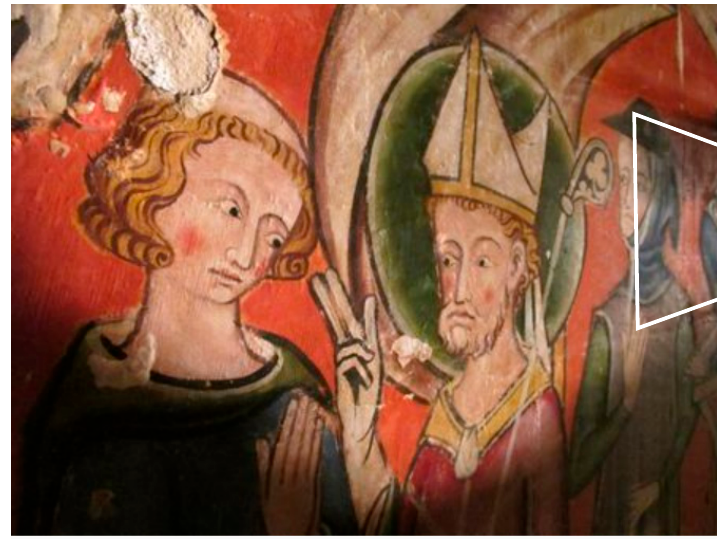
Figure 9. Mural painting "Saint Maurille en Evèque".